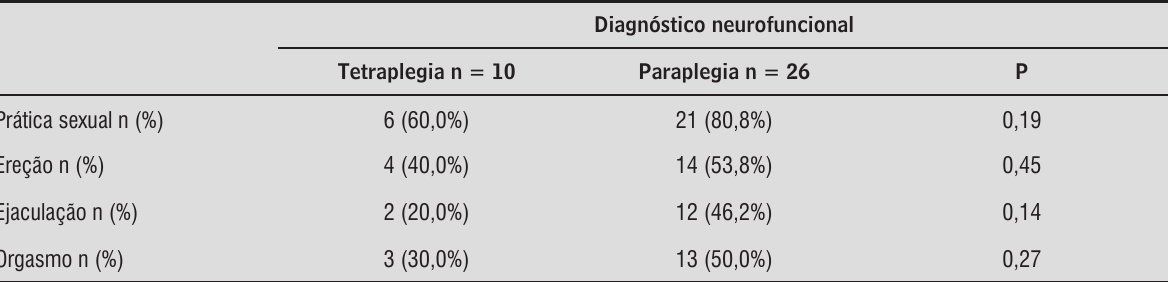
Tabela 4 - A satisfação sexual quanto à prática sexual após a LM Diagnóstico